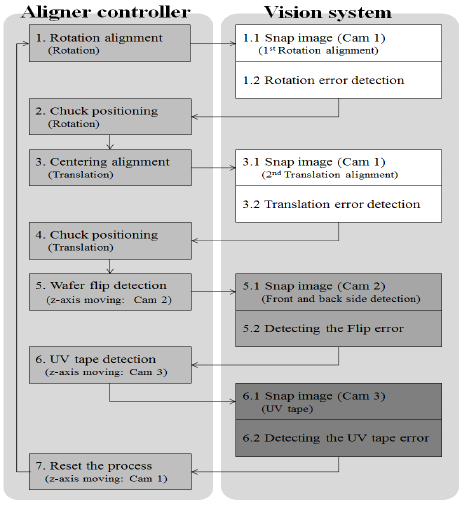
Figure 7. Operation steps of the aligner controller and vision system.